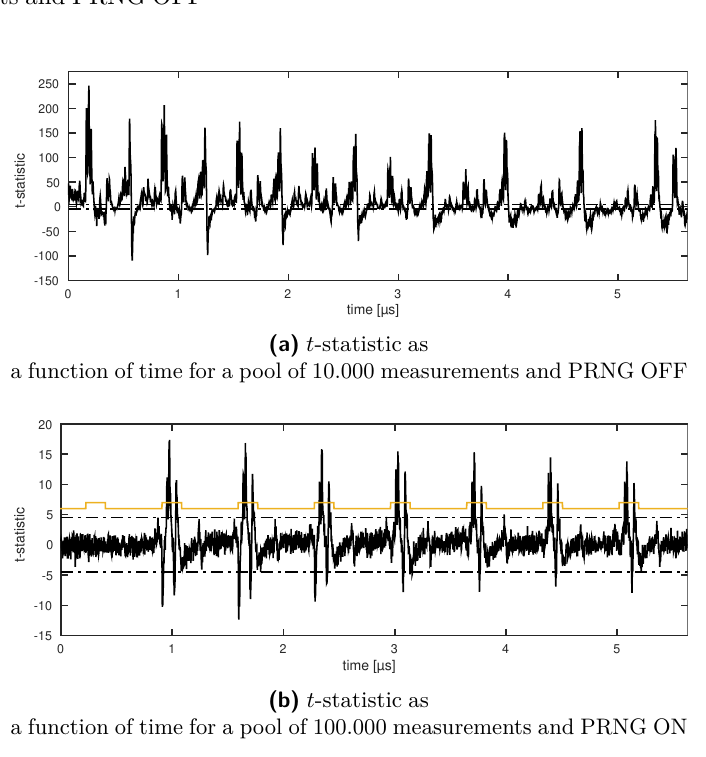
Figure 1: Mean power consumption of Debraize’s A2B conversion with a pool of 10.000 measurements and PRNG OFF